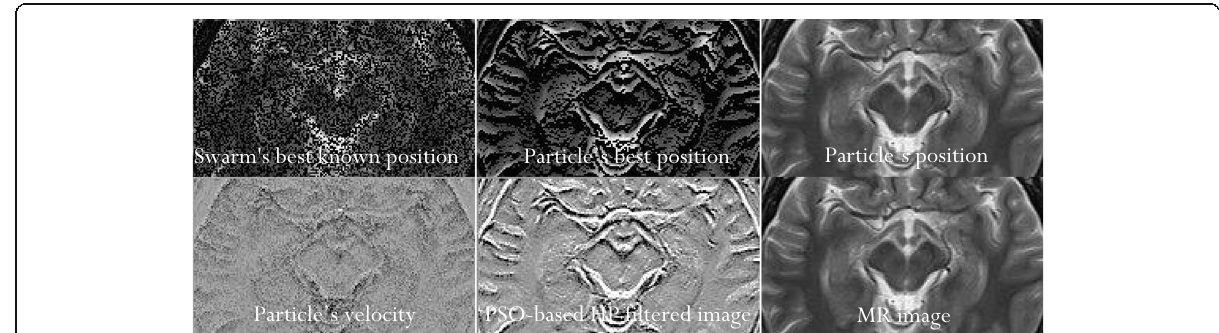
Fig. 13 Results of the optimization process of the particle swarm optimization algorithm for one case study. The relationships between the images are presented in the flowchart in Fig.